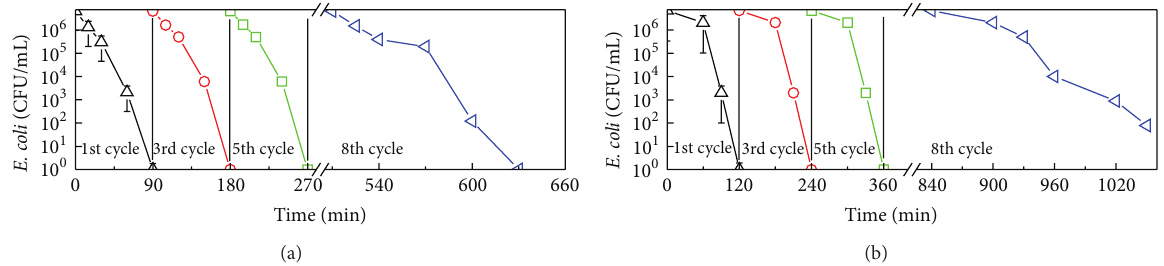
Figure 9: E. coli inactivation recycling experiments on TiO 2 /In 2 O 3 sputtered for 10min/10s on polyester under irradiation by: (a) Osram Lumilux T8-L 18 W (4.0 mW/cm 2 , 360 to 800 nm) and (b) Suntest solar simulator 50 mW/cm 2